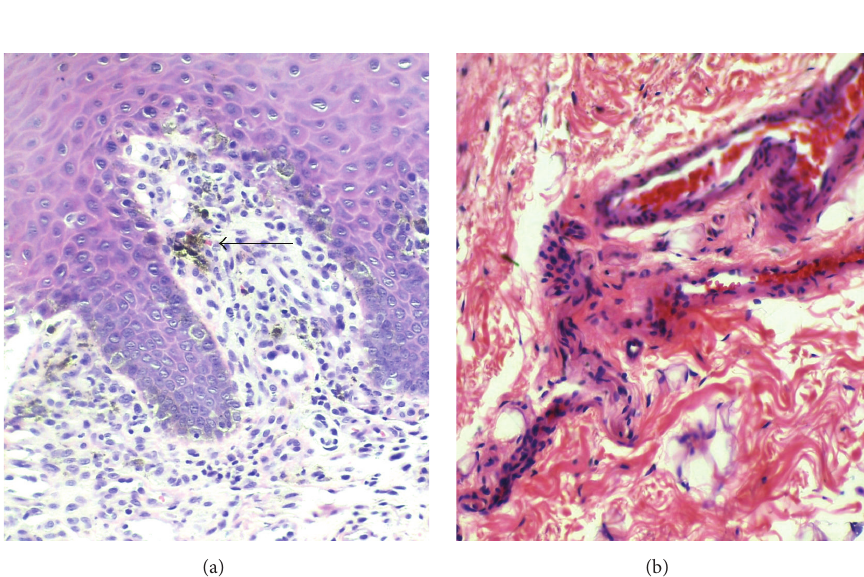
Figure 5: Connective tissue features in khat induced oral lesions. (a) Melanin pigment (arrow). (b) Fibrosis and tortuous blood vessels in the submucosa of chronic khat